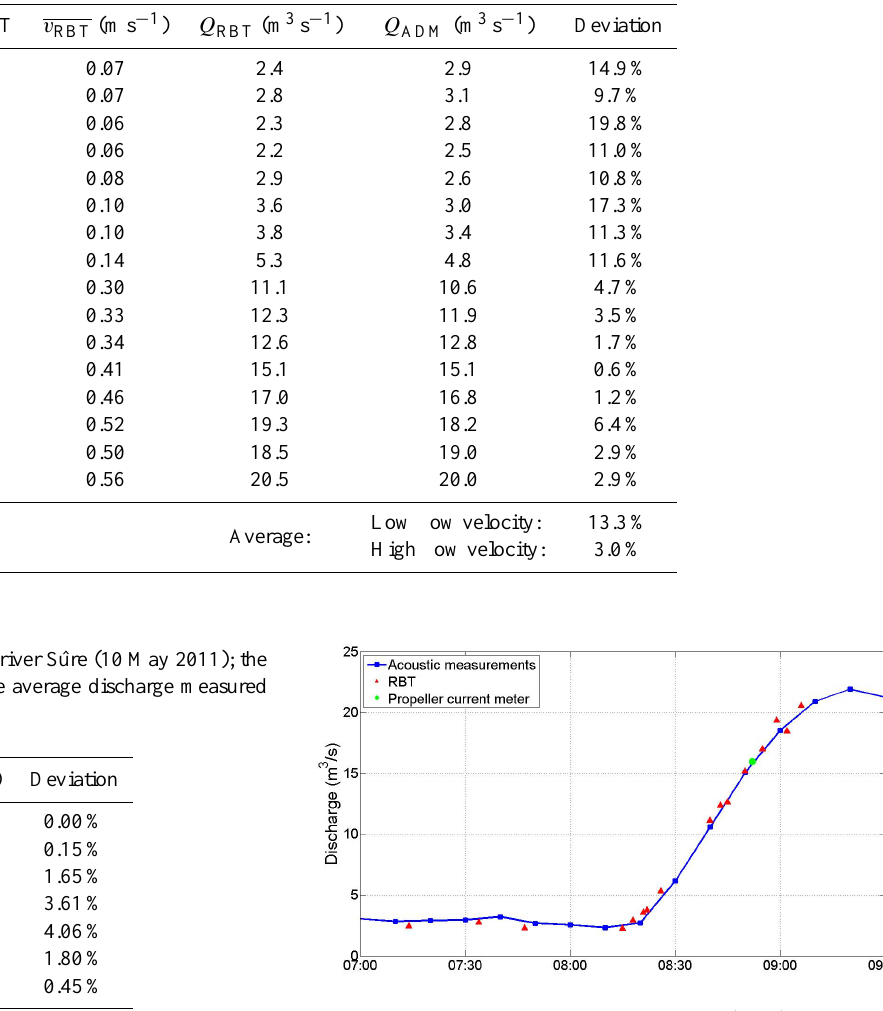
Fig. 8. Time-series of rising bubble technique (RBT) measurements plotted against acoustic discharge measurements (9 October